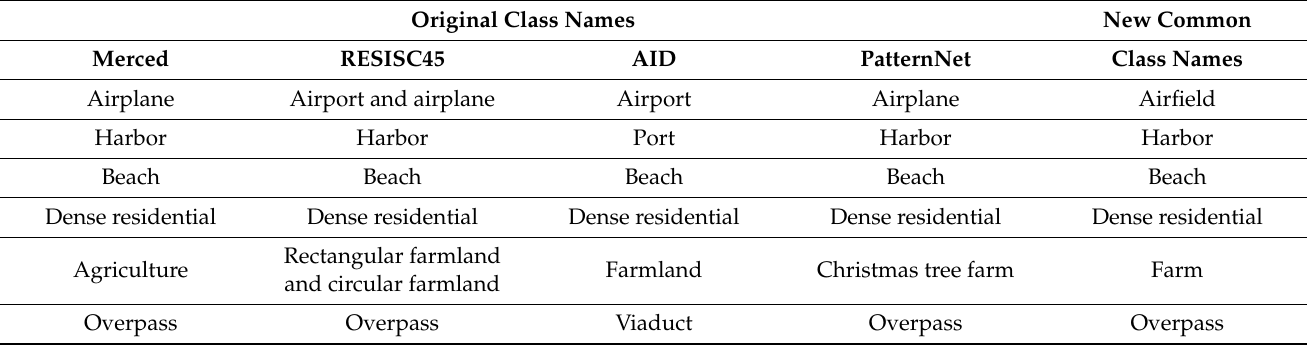
Table 2. List of twelve common classes in the four source